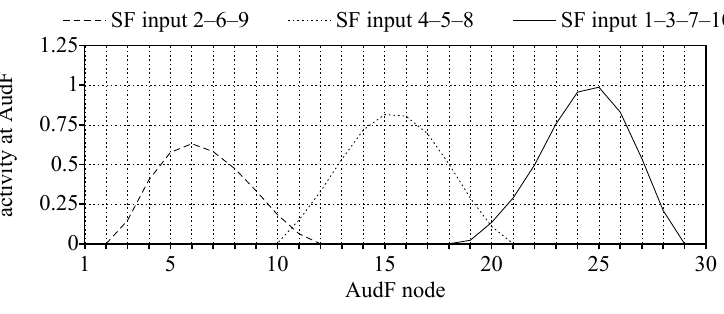
Production influenced by articulatory